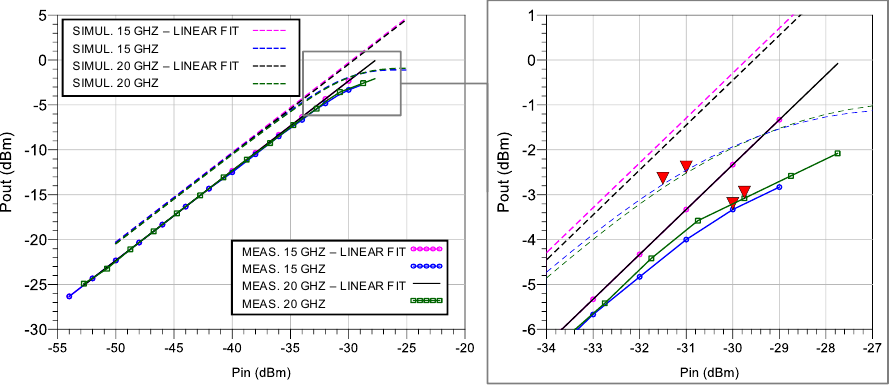
Figure 9. Measured and simulated 1 dB compression point at 15 and 20 GHz. Linear fits are provided together with markers identifying the 1 dB compression. The magnified view on the right side provides a detailed view around the 1 dB compression